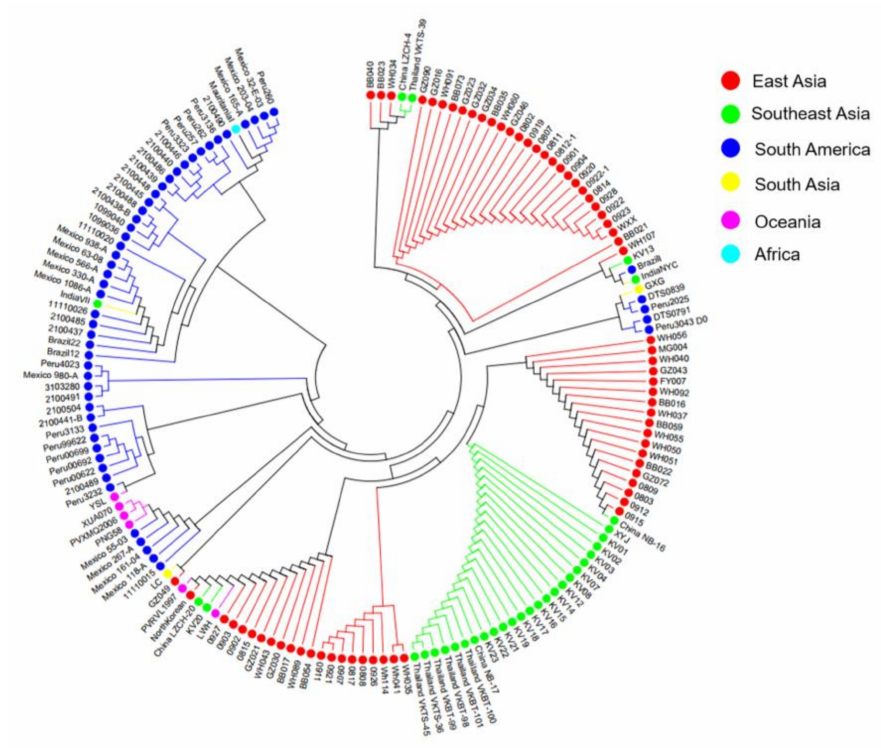
Figure 6. Phylogenetic relationship of pvmrp1 full-length genes in 166 isolates based on the neighbor- joining method. The evolutionary history was inferred using the neighbor-joining method. The optimal tree with the sum of branch length = 51.8479 is shown. The evolutionary distances were computed using the number of differences method and are in the units of the number of base differences per sequence. The analysis involved 166 nucleotide sequences. All positions containing gaps and missing data were eliminated. There were a total of 3373 positions in the final dataset. The color shows the geographical origin of the